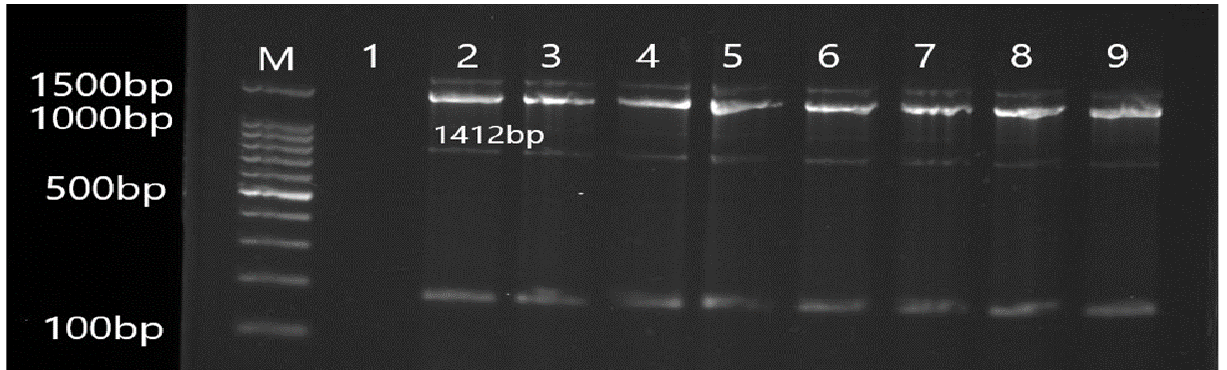
Figure 7. Electrophoresis showing amplicons of P. aeruginosa mexD gene. Lane M: 100 bp plus molecular marker, Lane 1: Negative control, Lane 2–9: Positive isolates of mexD gene.